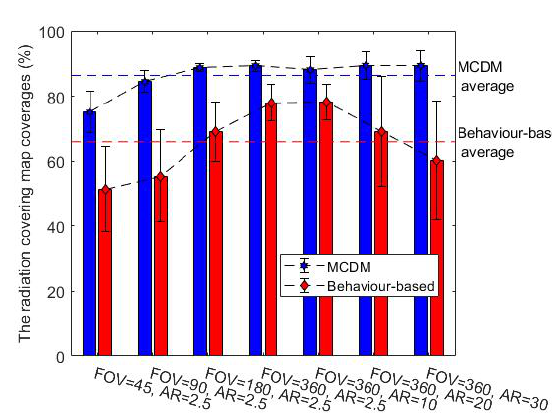
Figure 9. The radiation covering map coverage percentages for the environment B, average over ten trials.